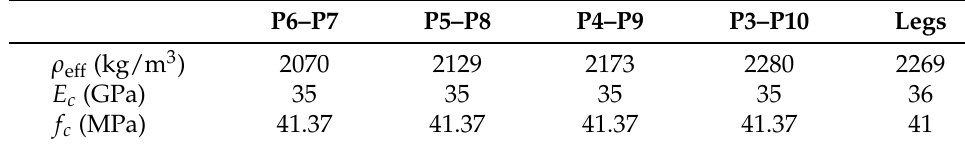
Table 5. Concrete properties